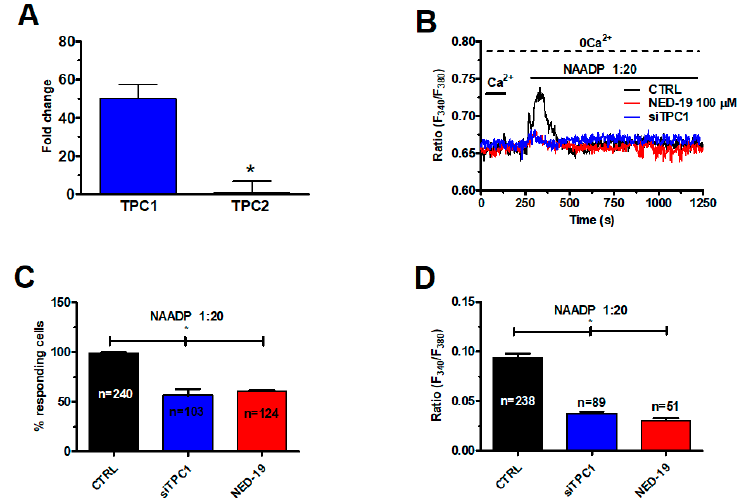
Figure 4. NAADP induces lysosomal Ca 2+ release in mCRC cells. ( A ) liposomal delivery of NAADP (1:20 dilution) caused a transient elevation in [Ca 2+ ] i in the absence of external Ca 2+ (0Ca 2+ ), while restoration of extracellular Ca 2+ did not cause any additional Ca 2+ signal. Control liposomes did not induce and detectable increase in [Ca 2+ ] i . ( B ) disrupting the lysosomal Ca 2+ store with GPN (200 µM, 30 min) severely affected the Ca 2+ response to NAADP (1:20 dilution). ( C ) mean ± SE of the percentage of responding cells in the absence and in the presence of GPN. The asterisk indicates p < 0.05. ( D ) mean ± SE of the amplitude of the peak Ca 2+ response to NAADP in the absence and in the presence of GPN. The asterisk indicates p < 0.05.